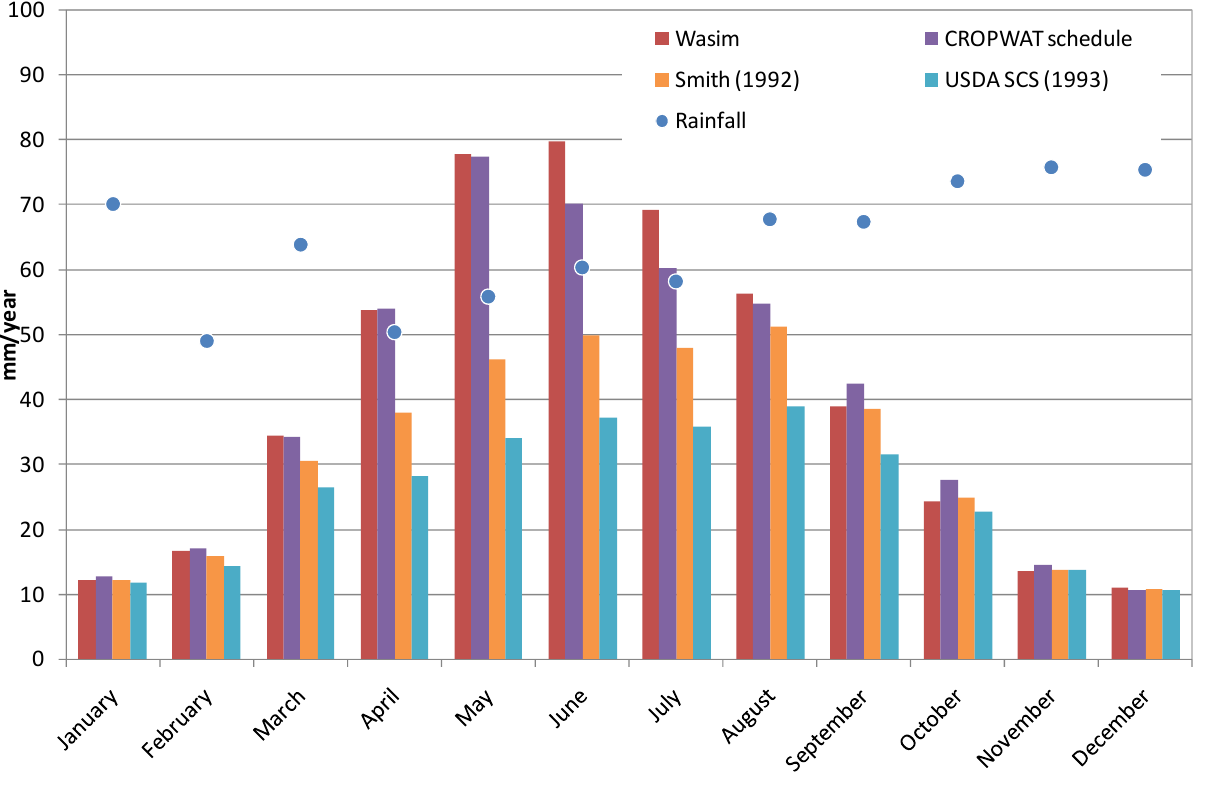
(mm/month) estimated using each green